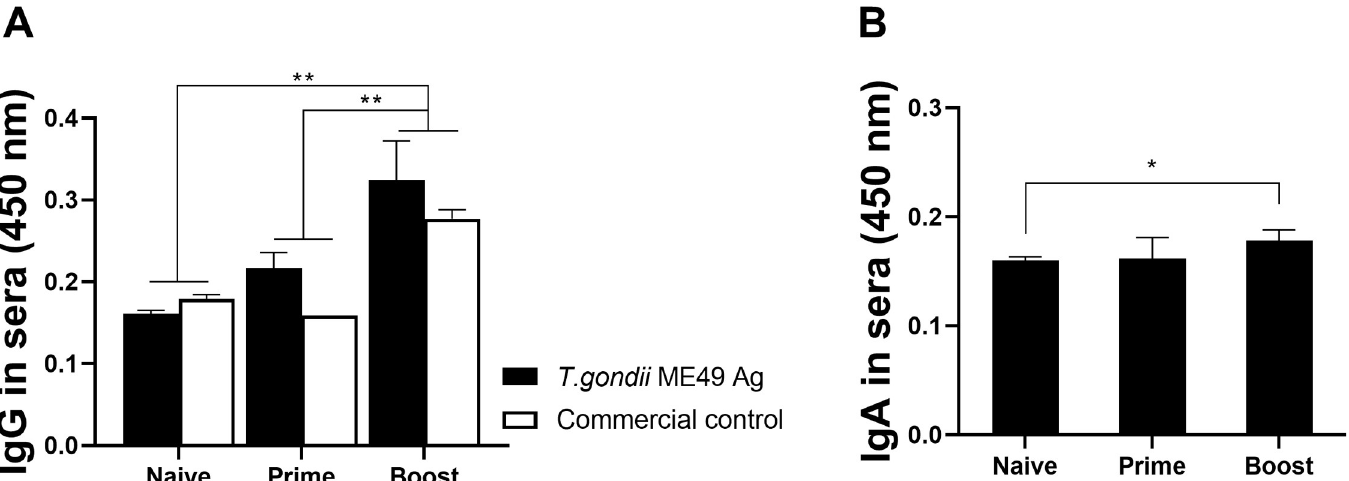
Fig 3. IgG and IgA in sera. Mice were intranasally immunized twice with CST1 VLPs at a 4-week interval and sera were collected 3 weeks after each immunization. T . gondii -specific IgG (A) and IgA (B) antibody responses from the sera were measured using ELISA. Absorbance values at 450nm were measured and data are shown as mean ± SD, with asterisks denoting statistical significance between the groups ( * P < 0.05, *** P < 0.001). Serum samples were collected on an individual basis and data are representative of 3 independent experiments performed in triplicates.